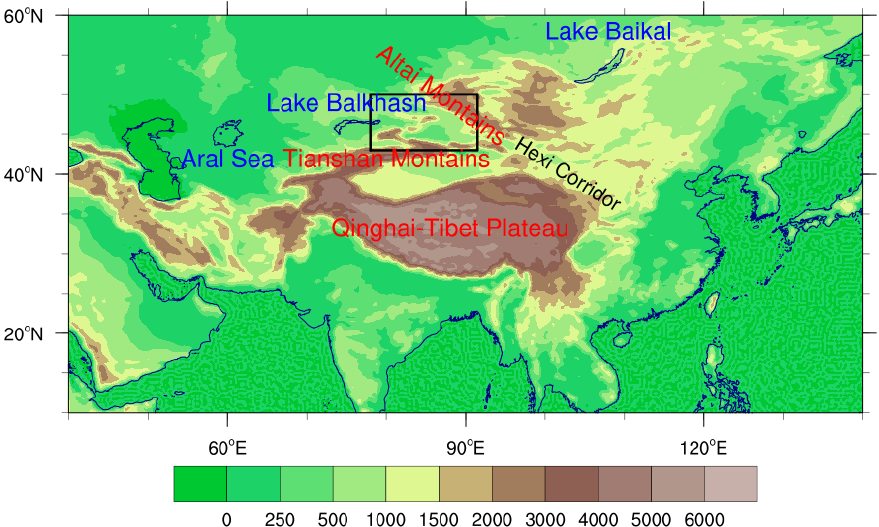
Figure 1. Topography of the surrounding area of the Northern Xinjiang region (Unit: m). The black box represents the location of the Northern Xinjiang region.